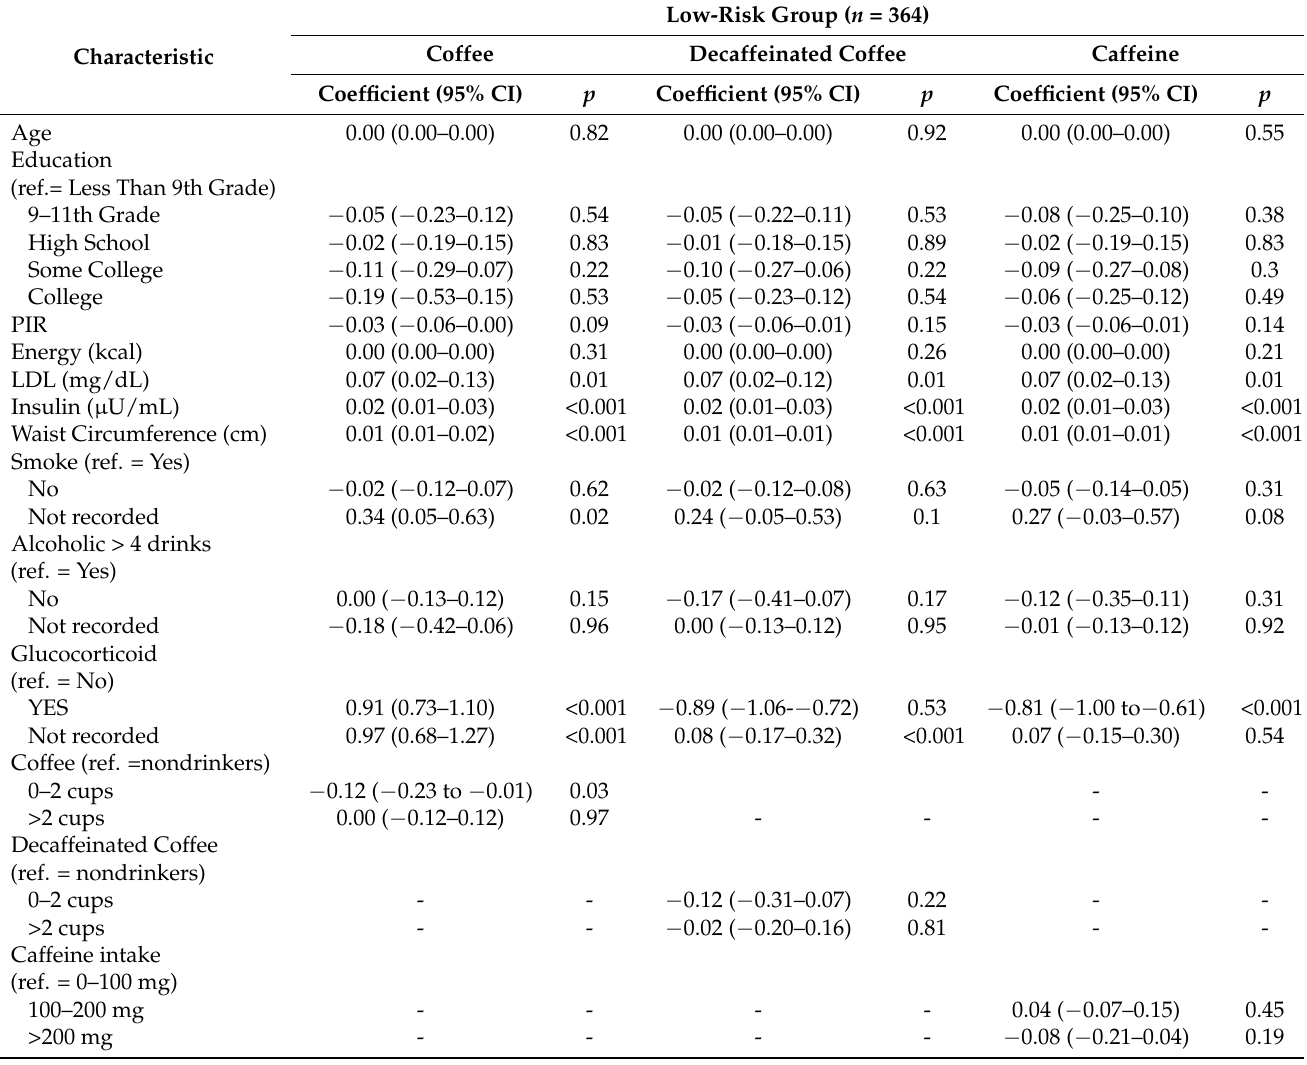
Table 5. Adjusted association between coffee, decaffeinated coffee, and caffeine intake and MetS z-score in low-risk